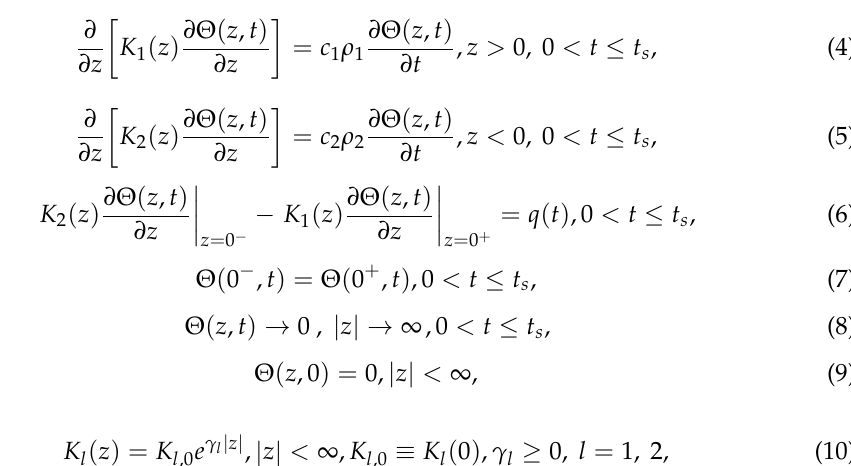
Figure 1. Scheme of the frictional heating in the disc–pad system. The temperature rise Θ = T − T a was determined from solution to the following one-dimensional boundary value problem of heat conduction taking into account the generation of heat due to friction: